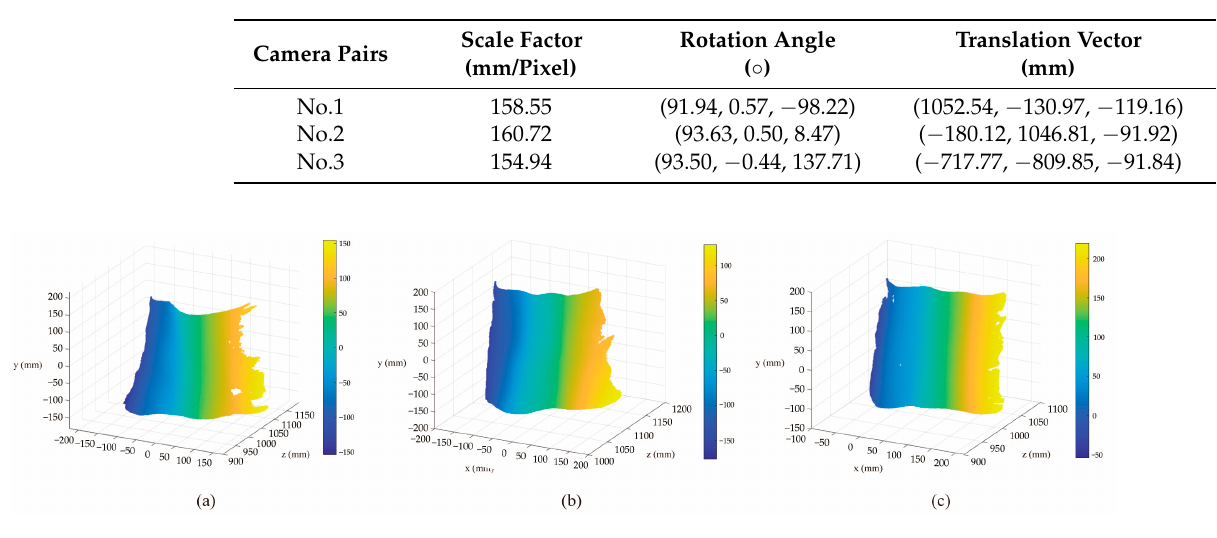
Figure 5. Real scale three-dimensional reconstruction results. ( a – c ) are the reconstructed surfaces of camera pairs C 1 , C 2 and C 3 , respectively. All units in the diagram are in mm